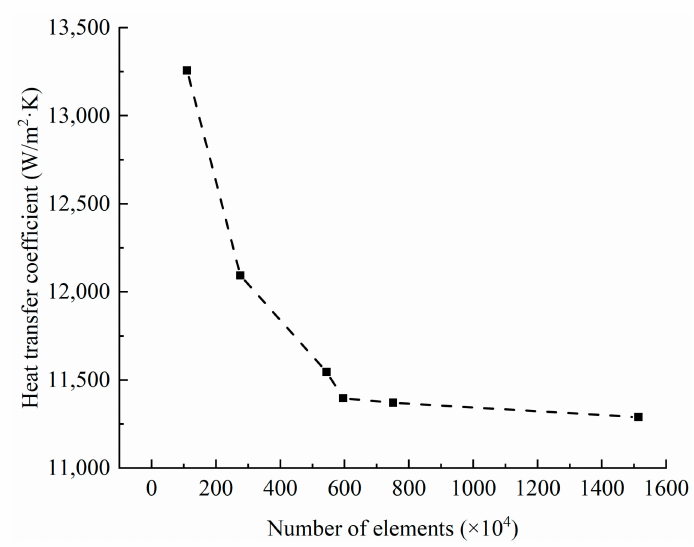
Figure 3. Heat transfer coefficient of the corrugated pipe with different numbers of elements.